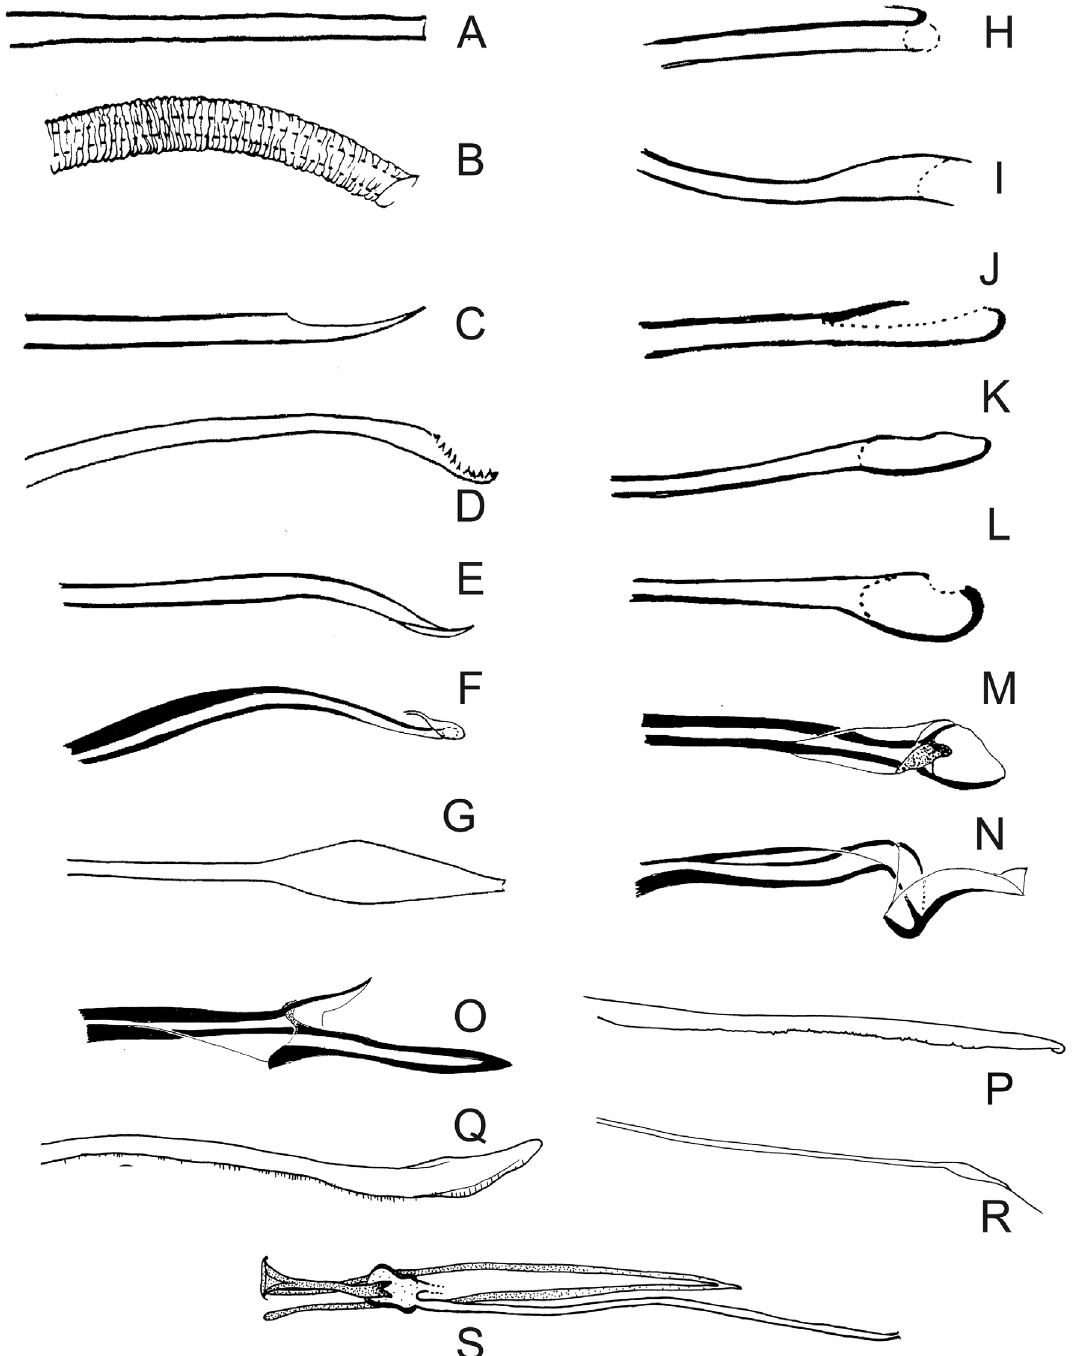
Figure 27. (A–R) Lateral view of terminal region of aedeagal ducts of Phlebotominae. (S) Genital pump, aedeagal ducts and hypandrial apodemes (abdominal rods). (A) Blunt apex: Lu. longipalpis ; (B) striated duct with blunt apex: Ev. brachyphalla ; (C) apex beveled: Pa. shannoni ; (D) curved and toothed apex: Ma. gasparviannai ; (E) curved and beveled apex: Mi. longipennis ; (F) duct curved in its preapical region and apex provided with appendix: Vi. tuberculata ; (G) lozenge apex: Pa. runoides ; (H) apex with barbs: Ny. yuilli pajoti ; (I–J) bifurcated apex: (I) Ny. whitmani ; (J) Nyssomyia anduzei , (K) ladle-shaped apex: Ny. intermedia , (L) spoon shaped or knife to eat fish shaped: Ny. neivai ; (M) clavate apex: Ev. walkeri ; (N) duct with curved preapical region and blunt apex: Pa. aragaoi ; (O) strongly sclerotized bifurcated apex: Ev. lenti ; (P) irregular side: Se. anka ; (Q) enlarged at the top: Se. sclerosiphon ; (R) with apical inflated portion: Id. padillarum . (S) Terminal region of aedeagal ducts with blunt apex: Id. nicolegerae